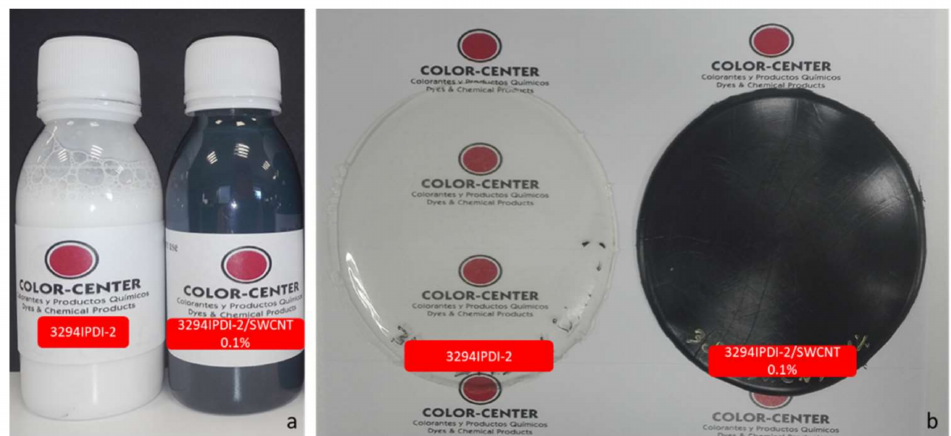
Figure 19. ( a ): 3294IPDI-2 WPUD dispersion before and after Tuball additivation. ( b ): casted films obtained after drying and curing in Teflon